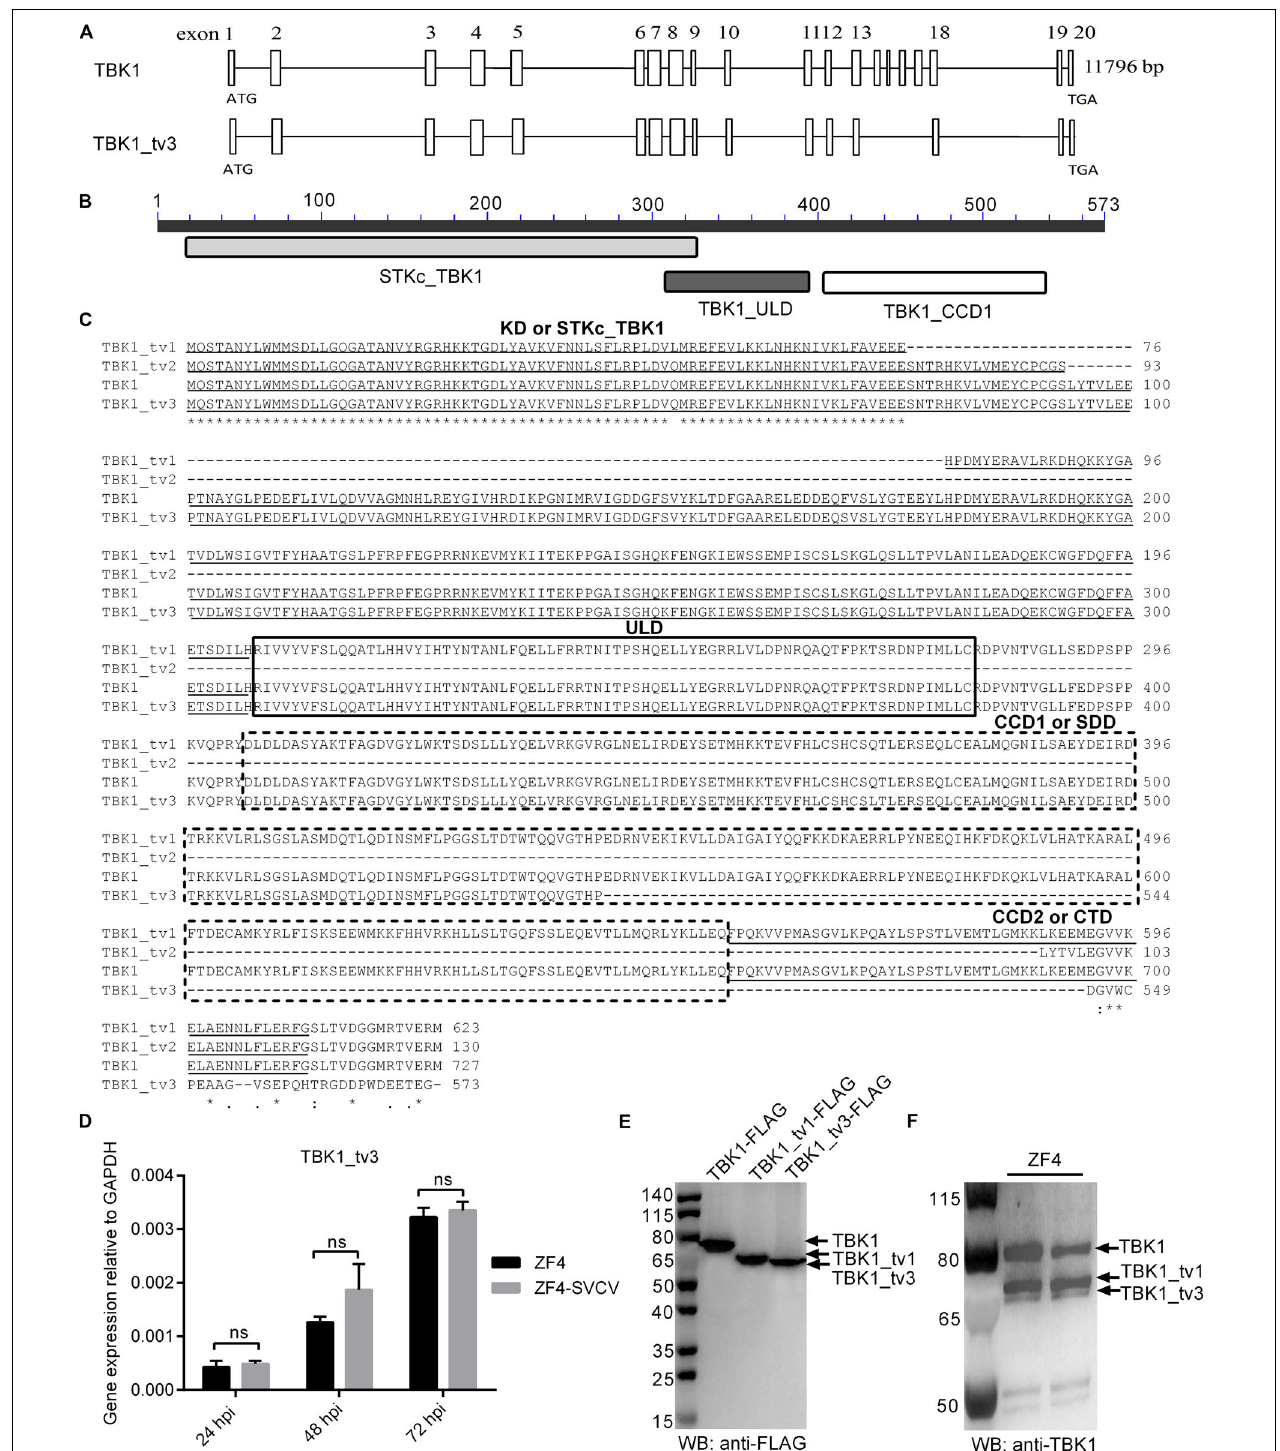
FIGURE 1 | Characterization of zebrafish TBK1_tv3 isoform. (A) The alternative splicing of zebrafish TBK1_tv3. (B) Protein domains of zebrafish TBK1_tv3. (C) Multiple alignments of amino acid sequences of zebrafish TBK1 and its isoforms TBK1_tv1, TBK1_tv2, and TBK1_tv3. (D) The mRNA expression of zebrafish TBK1_tv3 in ZF4 cells with/without SVCV infection. Total RNA was extracted from ZF4 including 24, 48, and 72 h post-infection. Data represented means ± SEM ( n = 3) and were tested for statistical significance. ns, not significant. (E) The exogenous expression of TBK1, TBK1_tv1, and TBK1_tv3 in EPC cells. (F) The endogenous expression of TBK1, TBK1_tv1, and TBK1_tv3 in ZF4 cells. For E,F , total protein was extracted at 24 h.